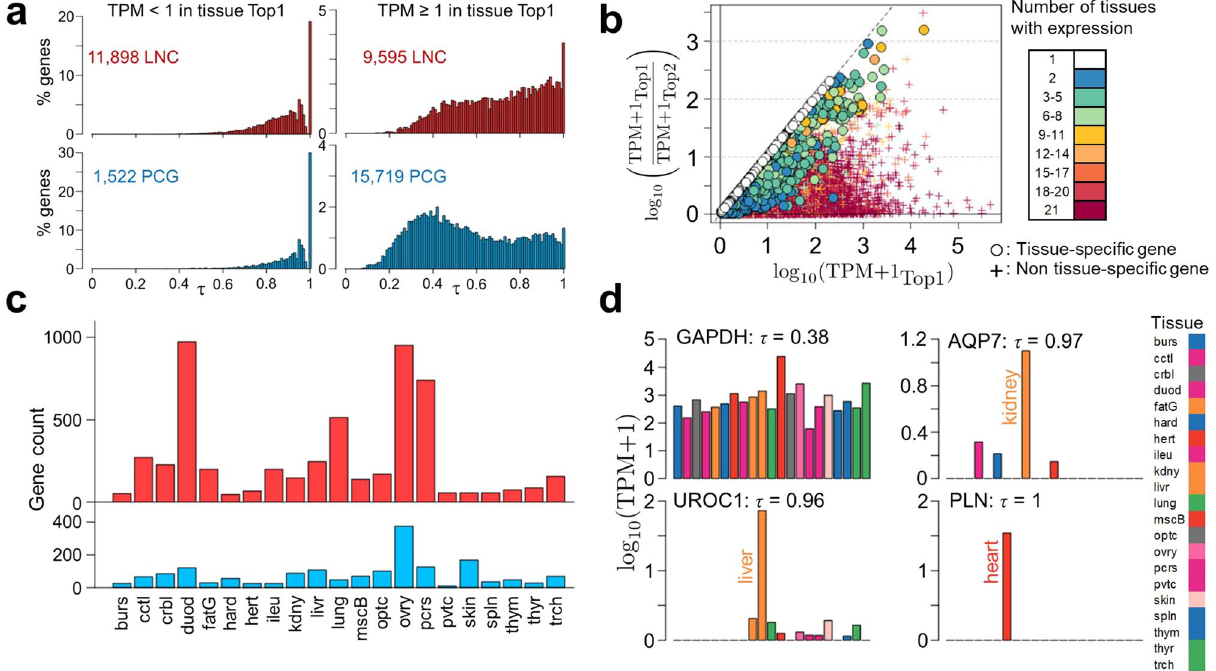
Figure 5. Overview of the tissue-specificity of PCG (in blue) and LNC (in red) in the 21 T dataset. ( a ) Distribution of τ values for LNC (top row) and PCG (bottom row) for two expression levels: TPM < 1 (left column) and TPM ≥ 1 (right column). The total number of corresponding genes is indicated in each plot. ( b ) For all the expressed genes (LNC and PCG), ratio of expression between the tissue with the highest expression (“Top1”) and the second tissue with highest expression (“Top2”) as a function of the expression in the tissue Top1. Colour indicates the number of tissues in which each gene is expressed, and the shapes differentiate the genes with a τ ≥ 0.95 (dots) versus τ < 0.95 (crosses). ( c ) Number of LNC (red) and PCG (blue) which are tissue- specific (τ ≥ 0.95) in each of the 21 tissues. ( d ) Expression profiles of 4 genes: the ubiquist GAPDH (top left), the tissues-specific AQP7 and UROC1 (top right and bottom left) and the heart-exclusive PLN (bottom right), expressed only in the heart. Tissues abbreviations are the same as in Fig.